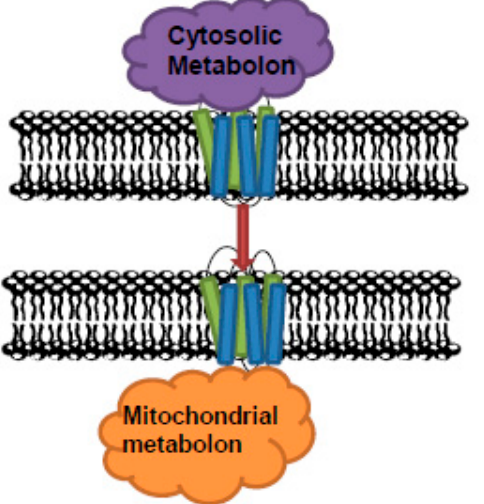
Figure 3. Metabolon associated to the mitochondrial carriers. The mitochondrial transport proteins may also join in the metabolon to improve the metabolite transport efficiency.